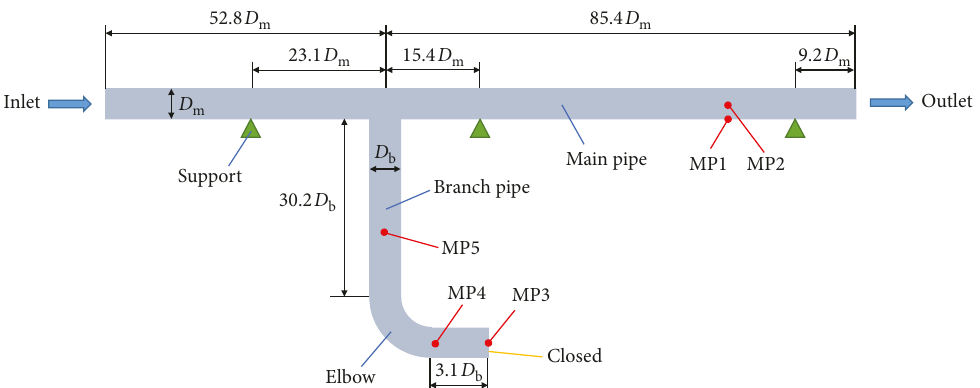
Figure 3: Geometry of the computational model and distribution of measuring points.